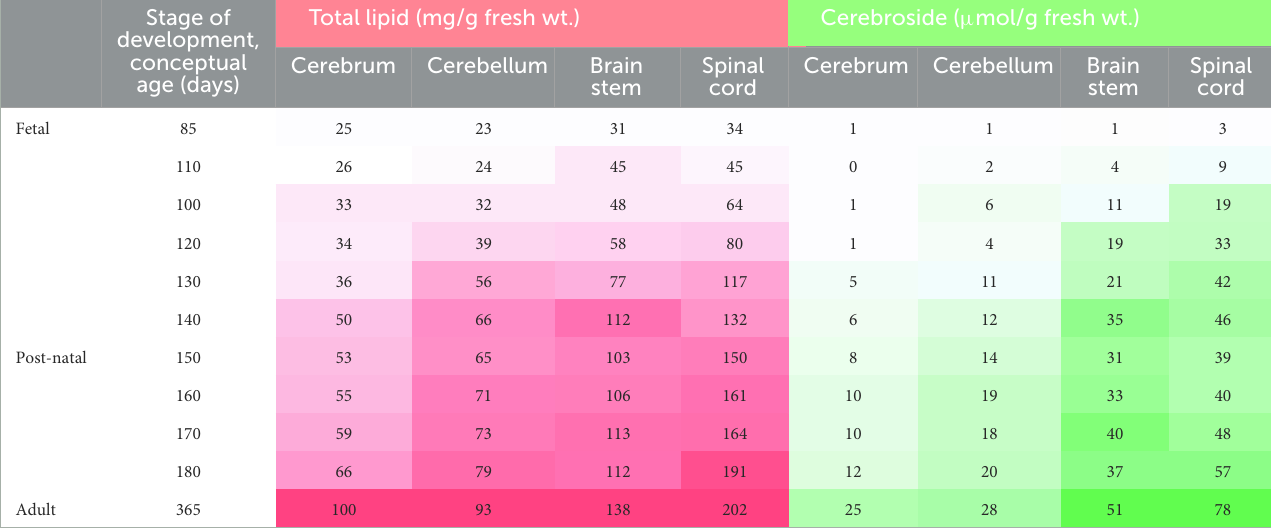
TABLE 2 Chemical composition of developing and adult sheep central nervous system divided by cerebrum, cerebellum, brain stem and spinal cord. Stage of Total lipid (mg/g fresh development, conceptual age (days)